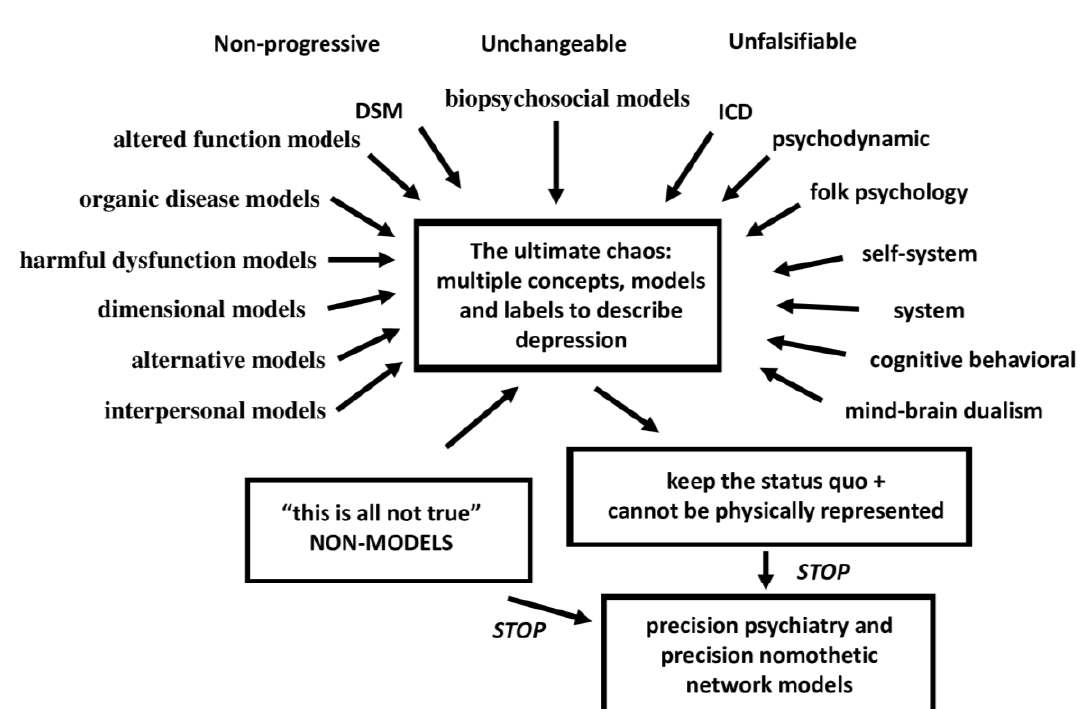
Figure 3. The status quo chaos and non-models of psychiatric depression concepts.